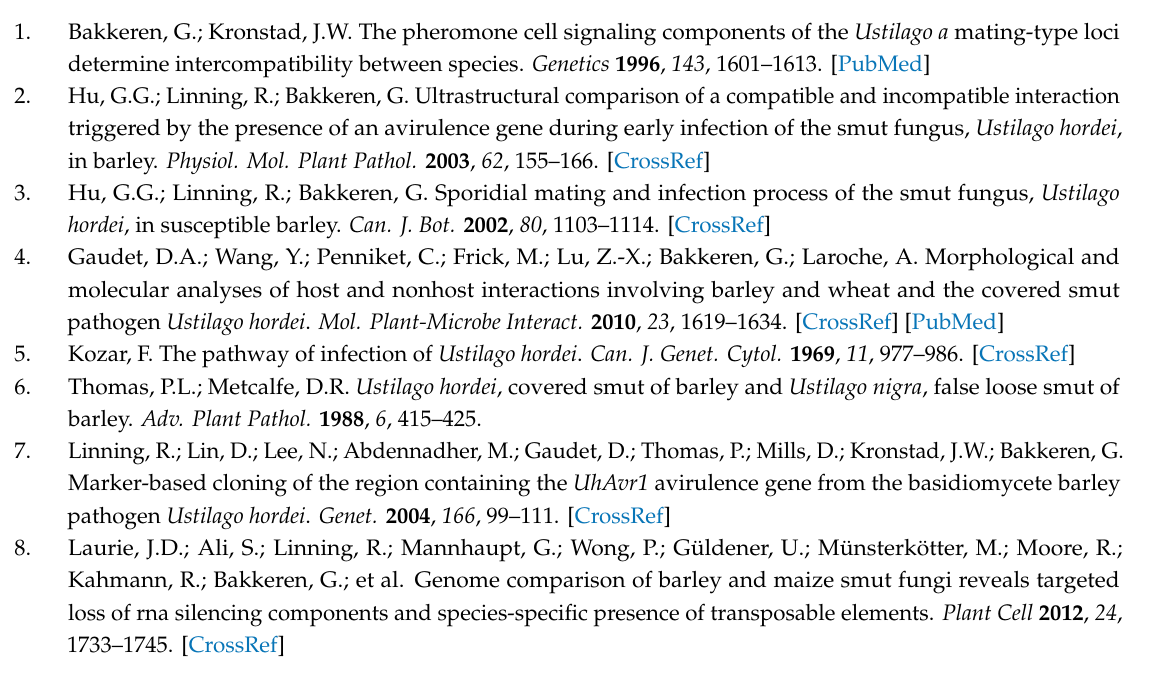
Figure S1. Constructs used during this study. Figure S2. Fungal structure observed during the infection with Ustilago hordei teliospores on barley coleoptiles. Figure S3. Symptoms on the leaves of N. benthamiana and barley plants expressing VOX constructs at later stages. Figure S4. GFP fluorescence from U. hordei strains expressing GFP-tagged UhAVR1 localize to the intercellular space of cv. Odessa cells. Figure S5. UhAVR1:GFP localizes to the cytosol of cv. Odessa cells at 48 hpi. Figure S6. Transcript and protein accumulation of UhAVR1 is a ff ected by the presence of a SP and the SP is cleaved o ff from the pre-protein in N. benthamiana . Figure S7. UhAVR1 does not co-localize with plant organelle markers. Figure S8. GFP expressed with the N-terminal SP of UhAVR1 localizes to the cytosol of N. benthamiana at 24 hpi. Figure S9. UmPit2:mCherry localizes to the apoplast in leaves of N. benthamiana . Figure S10. Brefeldin A exposure in N. benthamiana blocks tra ffi cking of proteins with the UhAVR1 SP. Table S1. Fungal strains used in this study. Table S2. Oligonucleotides used in this work. Table S3. UmPit2 e ff ector mRNA sequence with SP (underlined) and STOP codon. Table S4. Peptide sequence used to generate the UhAVR1 antibody. Table S5. Pathogenicity assays of N-terminally GFP-tagged UhAvr1 strains showed loss of